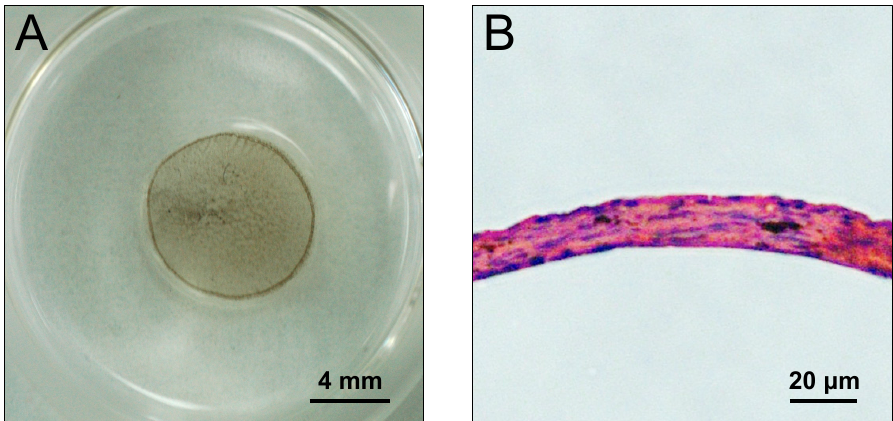
Figure 5. Photographs of a DEC sheet created by the Mag-TE system. DECs labeled with MNPs were seeded into a 24-well ultra low attachment culture plate (Corning Inc., Corning, NY, USA) at 2 × 10 6 cells/plate. A cylindrical neodymium magnet (magnetic force, 4110 G) was placed on the reverse side of the ultra low attachment plate, and the cells were cultured for 24 h. After the culture, the cell sheet was constructed ( A ). Microscopic image of an HE-stained cross section of a DEC sheet (×100) ( B ).